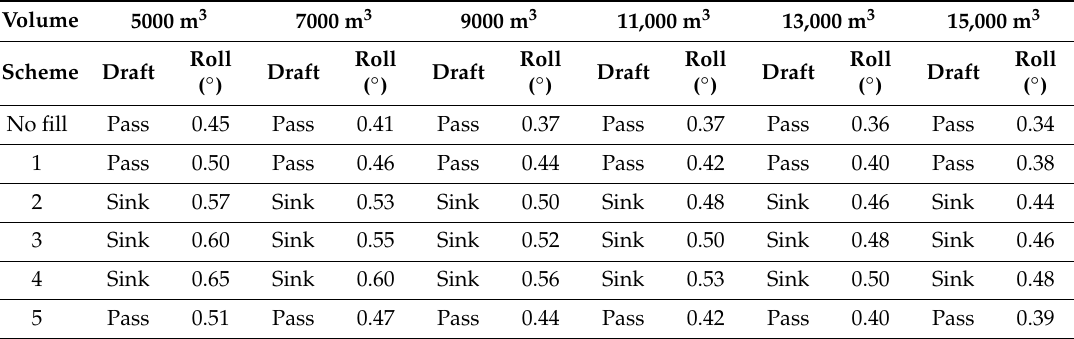
Table 9. Results of storage tank with D / H = 2.0, L / D =